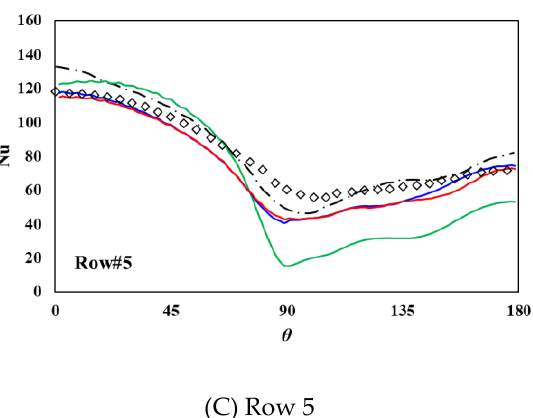
Figure 8. Nusselt number distributions along line C in rows 1, 3, and 5.